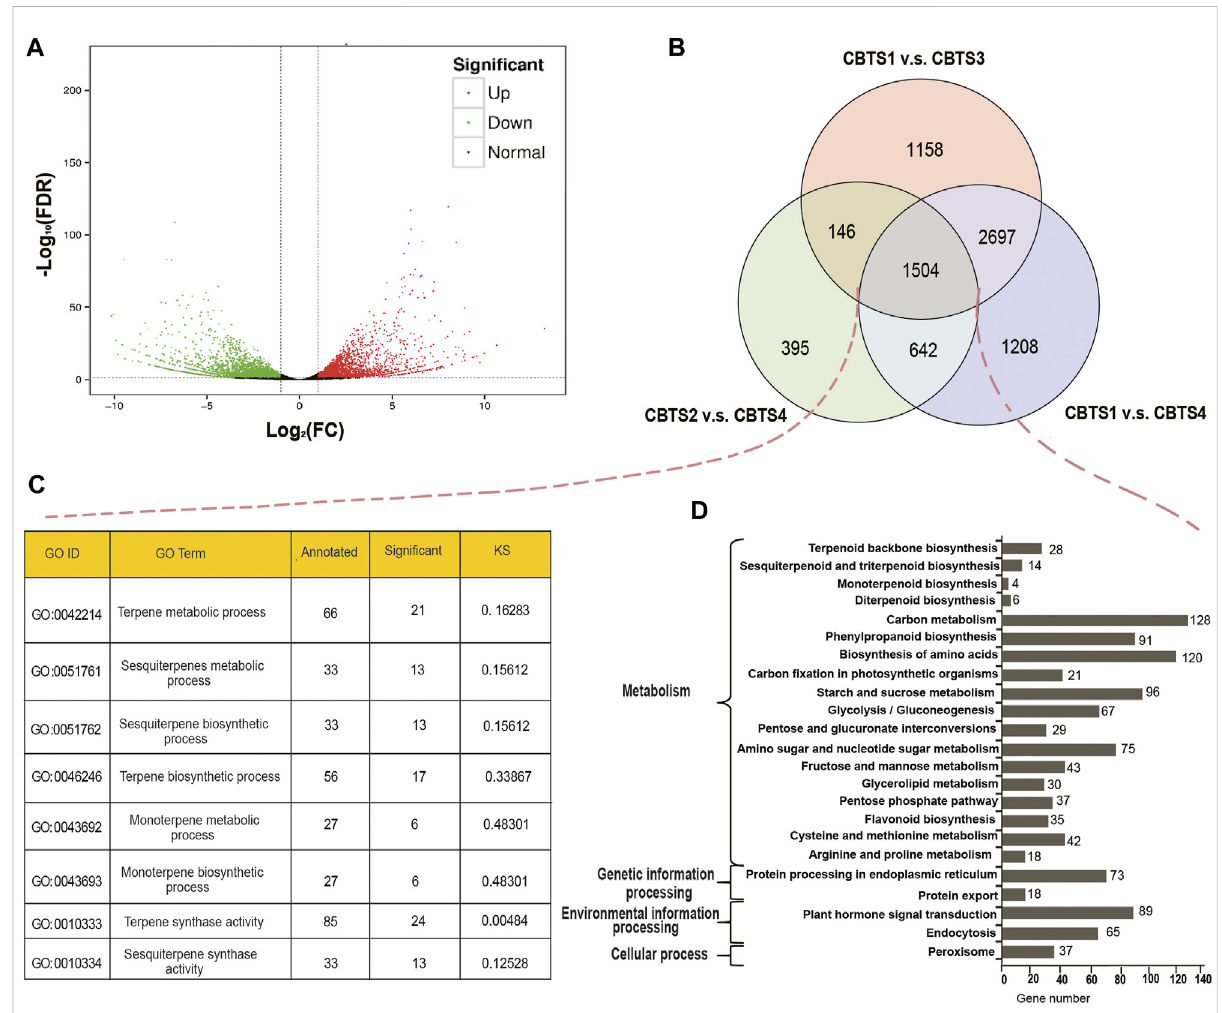
FIGURE 3 Differentiallyexpressedgenes(DEGs)of Cinnamomumburmannii leavesacrossfourdevelopmentalstagesandtheirannotations. (A) Avolcano plotshowsthenumberofDEGsbetweenCBS1andCBS4inred(upregulatedgenes)andgreendots(downregulatedgenes). (B) Venndiagramshows theoverlapinDEGs. (C,D) GOenrichmentanalysisoftheoverlappingDEGsbetweenCBS1andCBS3,CBS2andCBS4,andCBS1andCBS4. (D) KEGG (Kyoto Encyclopedia of Genes and Genomes) enrichment analysis of the overlapping DEGs between CBS1 and CBS3, CBS2 and CBS4, and CBS1 and